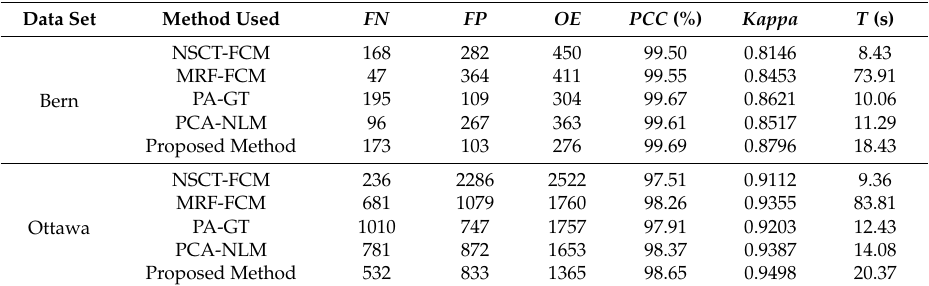
Table 1. SAR image change detection results under evaluation by different algorithms.